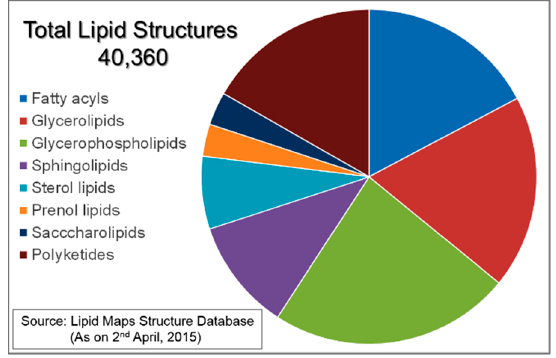
Figure 1. Main categories of lipid structures deposited on Lipid Maps Structure Database [7].